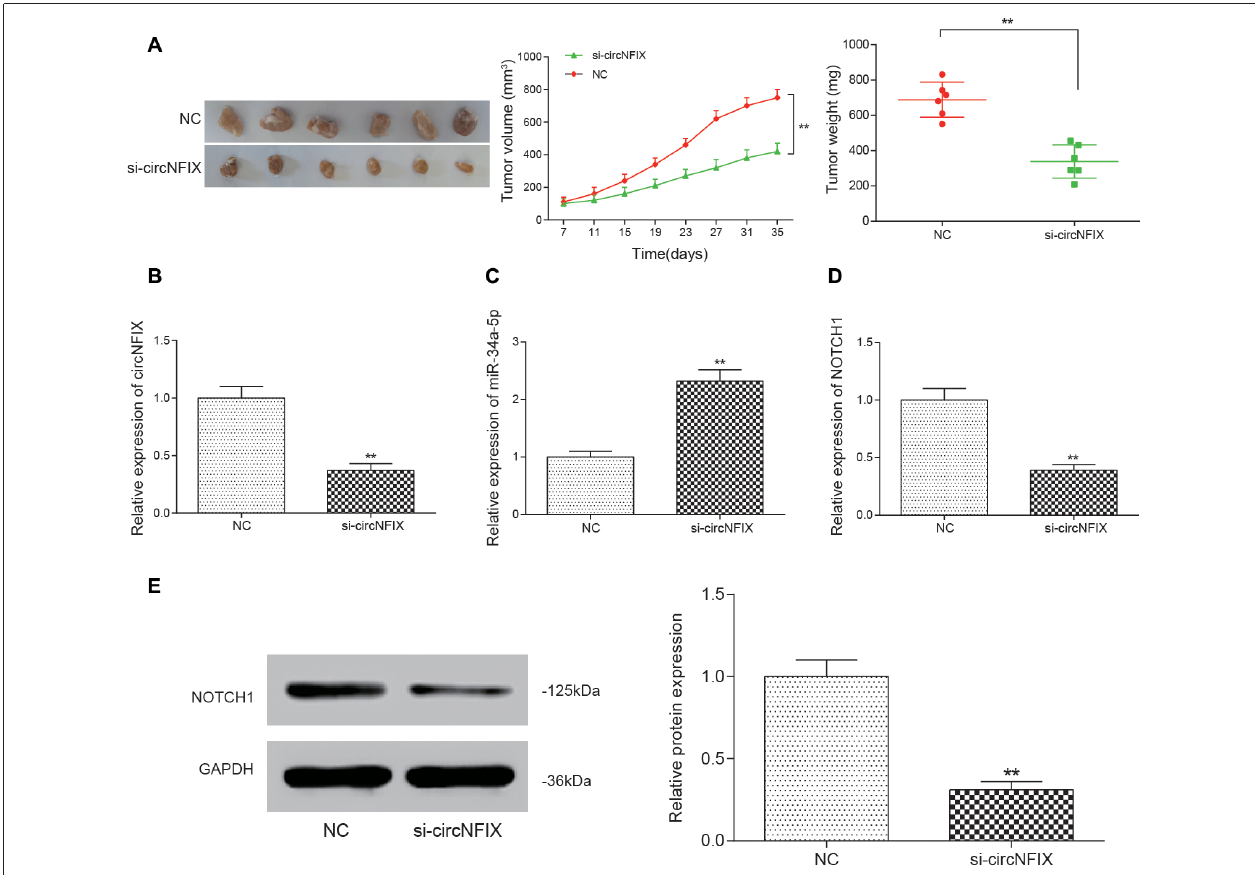
FIGURE 7 | Si-circNFIX inhibited the progression of glioma in vivo . (A) The nude mouse tumor transplantation experiment proved the suppressive effect of si-circNFIX on the growth of glioma. (B–D) The qRT-PCR assay analyzed the expression of circNFIX, miR-34a-5p and NOTCH1 after U87 cells were transfected with si-circNFIX. (E) Western blotting analyzed the protein expression after transfection with si-circNFIX. ∗∗ P < 0.01 compared with the NC group.